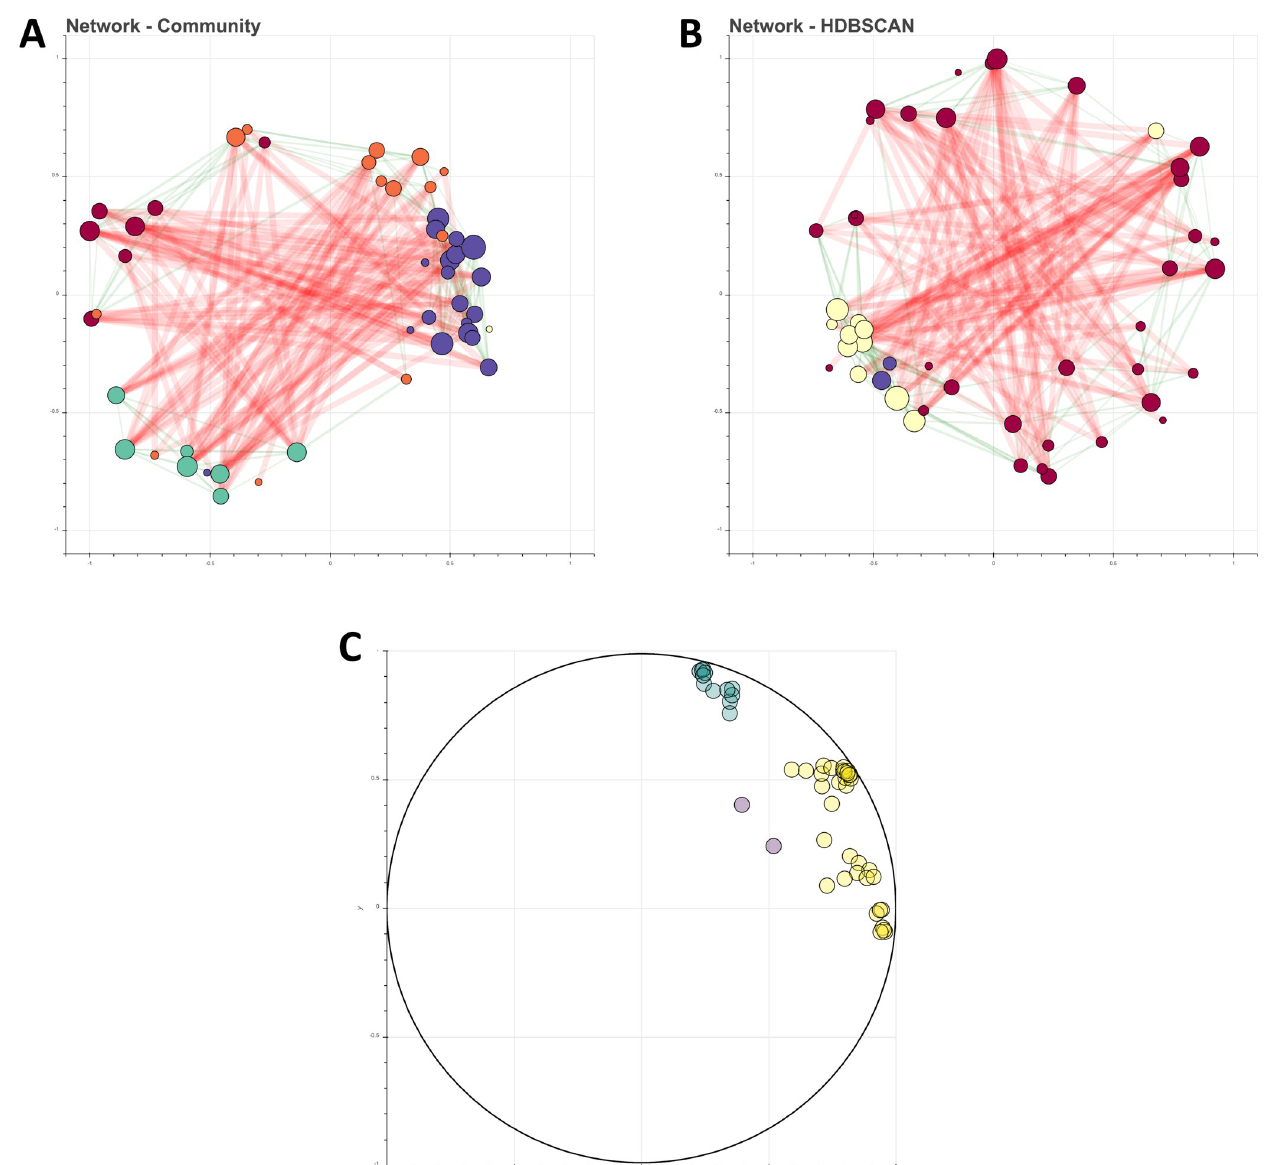
Fig 6. Kombucha microbial network. A . SparCC co-occurrence network, where colors indicate Louvain groups. B . SparCC co-occurrence network, where color indicates the resulting HDBSCAN clusters. In purple is shown the group depicted as noise. C . UMAP and HDBSCAN results show one main group and a smaller one of 12